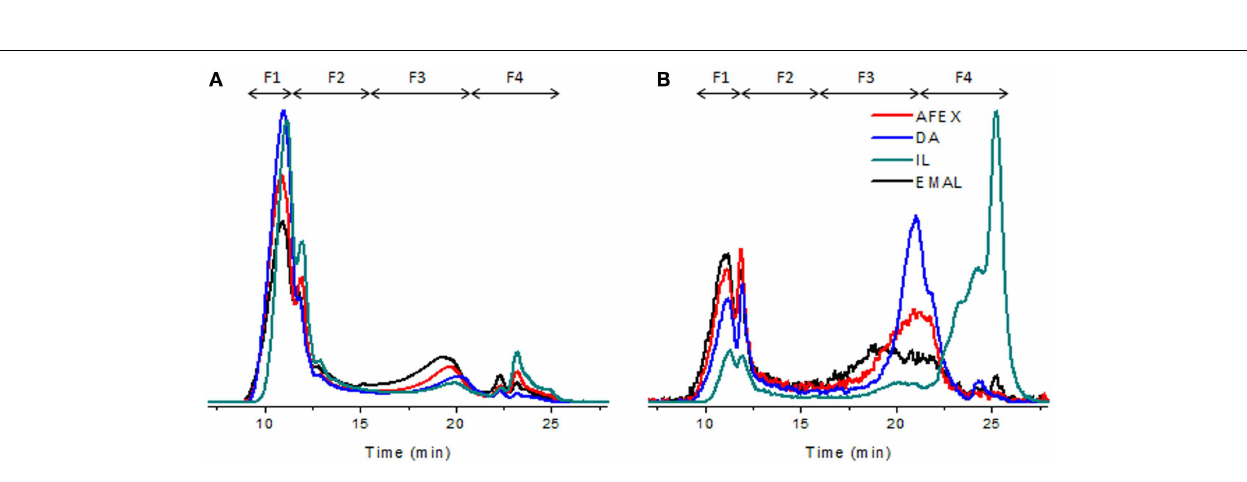
FIGURE 8 |Area-normalized SEC elution profiles of lignin before and after pretreatments . (A) UVA; (B) UVF.